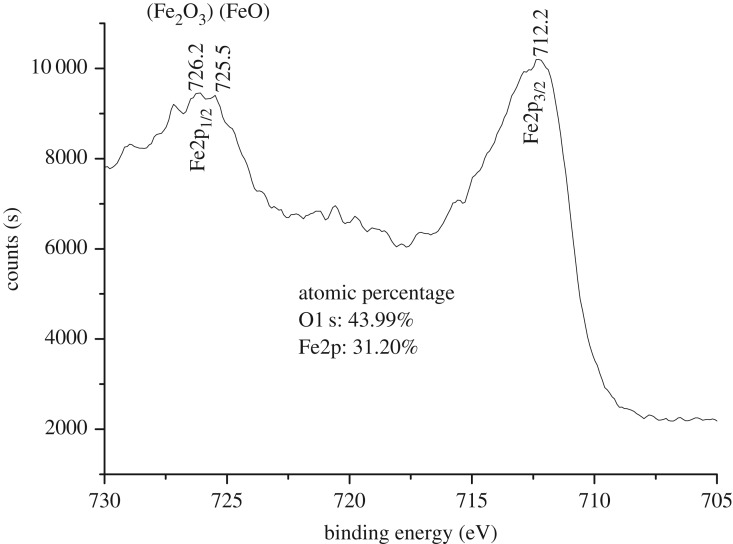
XPS spectrum of Fe3O4.